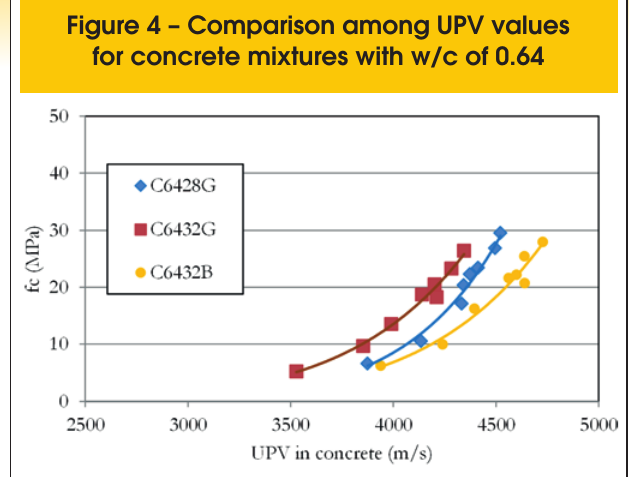
Figure 3 – Comparison among UPV values for concrete mixtures with w/c of 0.55